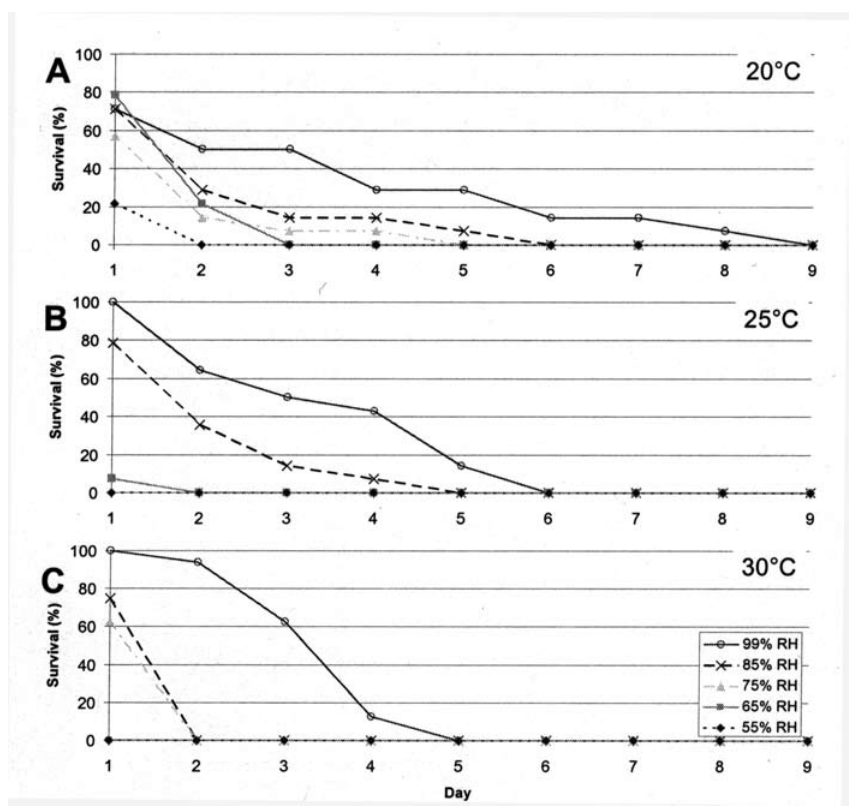
Fig. 7. Survival of C. formosanus alates at A) 20°, B) 25°, and C)